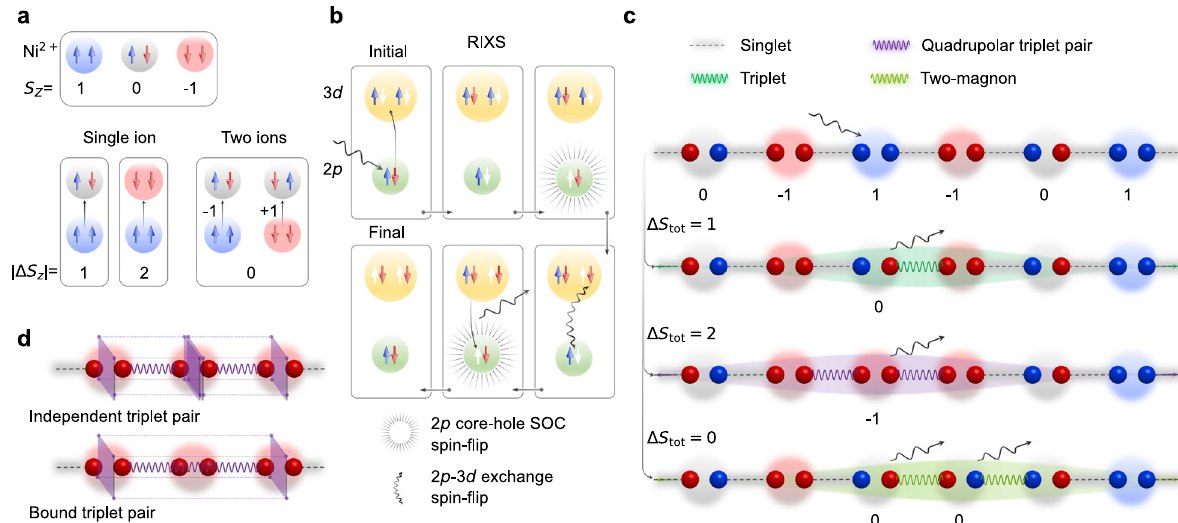
Fig. 1 Magnetic excitations in S = 1 Haldane chains. a Possible unpaired spin con fi gurations in an S = 1 ion (Ni 2 + ) and spin- fl ip transitions. b Process of probing single-site quadrupolar Δ S tot = 2 excitations in L -edge RIXS. An L -edge RIXS process of a S = 1 3 d 8 ion (with two unpaired d electrons and ground state having S tot = 0) proceeds via creation of an intermediate 2 p 5 3 d 9 state. In this intermediate state, due to the strong spin-orbit coupling of 2 p 5 core- hole, the spin-angular momentum is not conserved leading to a valence orbital spin- fl ipped fi nal state with S tot = 1. Additionally, due to the many-body core-valence Coulomb exchange interactions in the intermediate states, an additional available valence orbital spin- fl ip may occur thereby creating an excited fi nal state with S tot = 2 21 . The coloured (white) arrows represent the occupied (empty) spin states of the electrons involved in the scattering process. c A representative Haldane spin chain characterised by the topological non-local (string) order of alternating S z = ±1 sites intervened by any number of S z = 0 sites. Between neighbouring sites a pair of spin-1/2s form an antisymmetric singlet. Single-site single spin- fl ips give rise to dipolar singlet- triplet excitations while single-site double spin- fl ips give rise to quadrupolar excitations resulting in pairs of triplets. Single spin- fl ips at multiple sites give rise to two-magnons. d Schematic representation of dual nature of propagation of the pair of triplets formed after quadrupolar